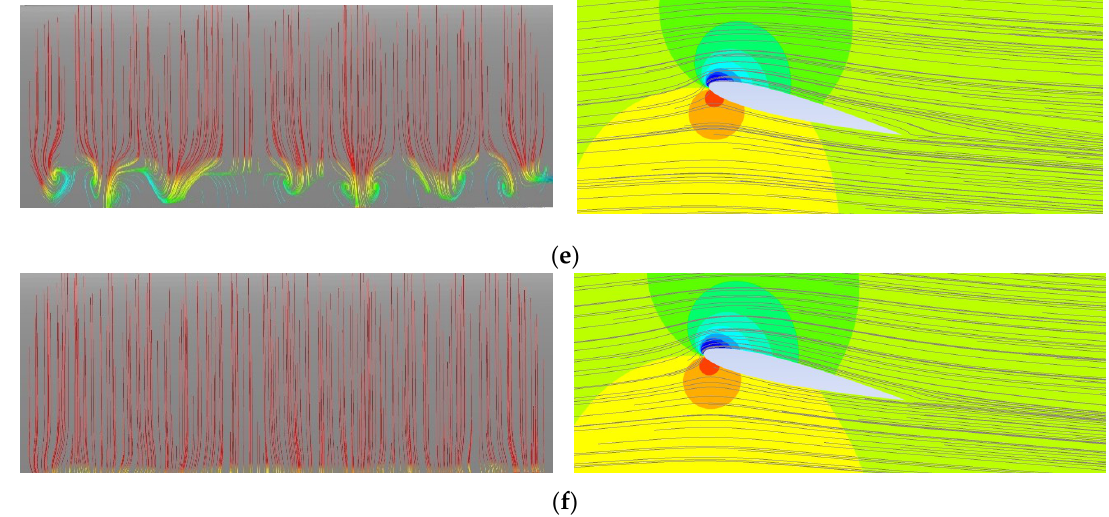
Figure 11. Weak stall cells on the aerofoil surface. Maximum AoA = 23°, f = 0.025. ( a ) AoA = 17.69° ↓ ; ( b ) AoA = 16.87° ↓ ; ( c ) AoA = 16.00° ↓ ; ( d ) AoA = 15.10° ↓ ; ( e ) AoA = 14.17° ↓ ; ( f ) AoA = 13.20° ↓ .